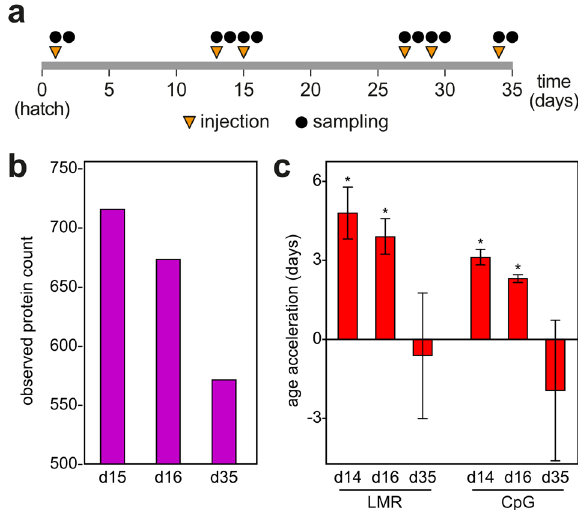
Fig. 5 Intestinal in fl ammation is associated with age acceleration in broiler chickens. a Schematic outline of the in fl ammation trial. After hatching (day 0), animals were periodically injected with CpG (or control GpC) oligonucleotide, as shown (orange tringles). At several timepoints (black circles), animals were euthanized and tissue was collected for analysis. b In fl ammatory kinase activation in jejunum samples with experimentally induced in fl ammation. The number of observed differentially phosphorylated proteins in the top 10 immune related GO terms were counted for CpG injected broiler chickens at each day. At day 35 post-hatch, a substantial reduction in protein phosphorylation changes related to immunity was observed. c Age acceleration in jejunum samples with experimentally induced in fl ammation. The speci fi c age acceleration in the d13-16 age group matches the immunological phenotype. Asterisks indicate statistically signi fi cant differences in relation to day 35 ( P < 0.05, t